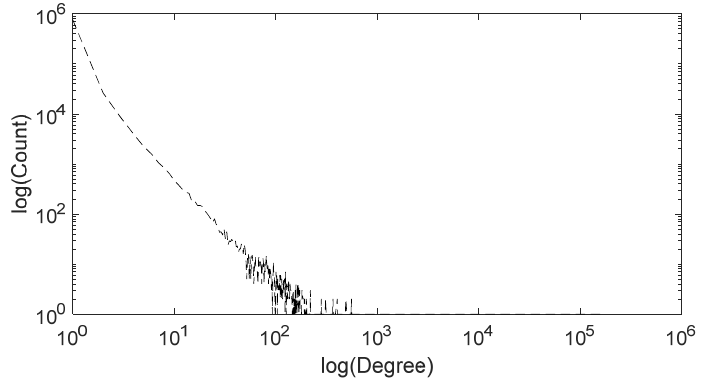
Figure 8. Frequency of prefixes according to their degrees in log scale.